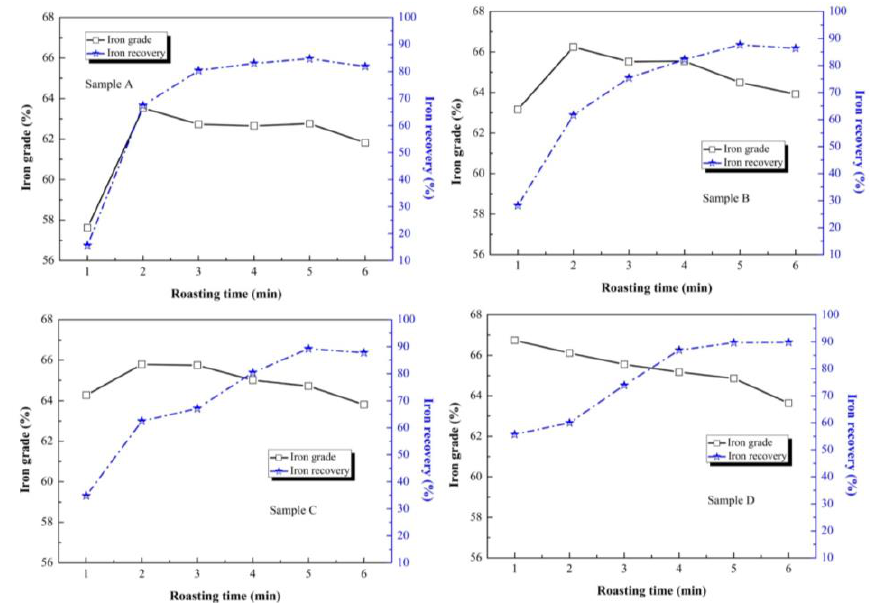
Figure 8. The iron grade and iron recovery of sample A to D with different roasting times.